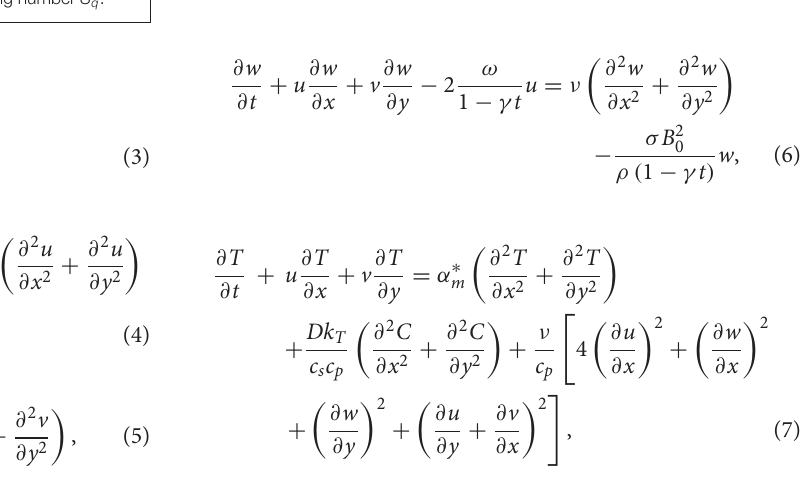
FIGURE 4 | Sketch of velocity distribution G (η) for squeezing number S q .